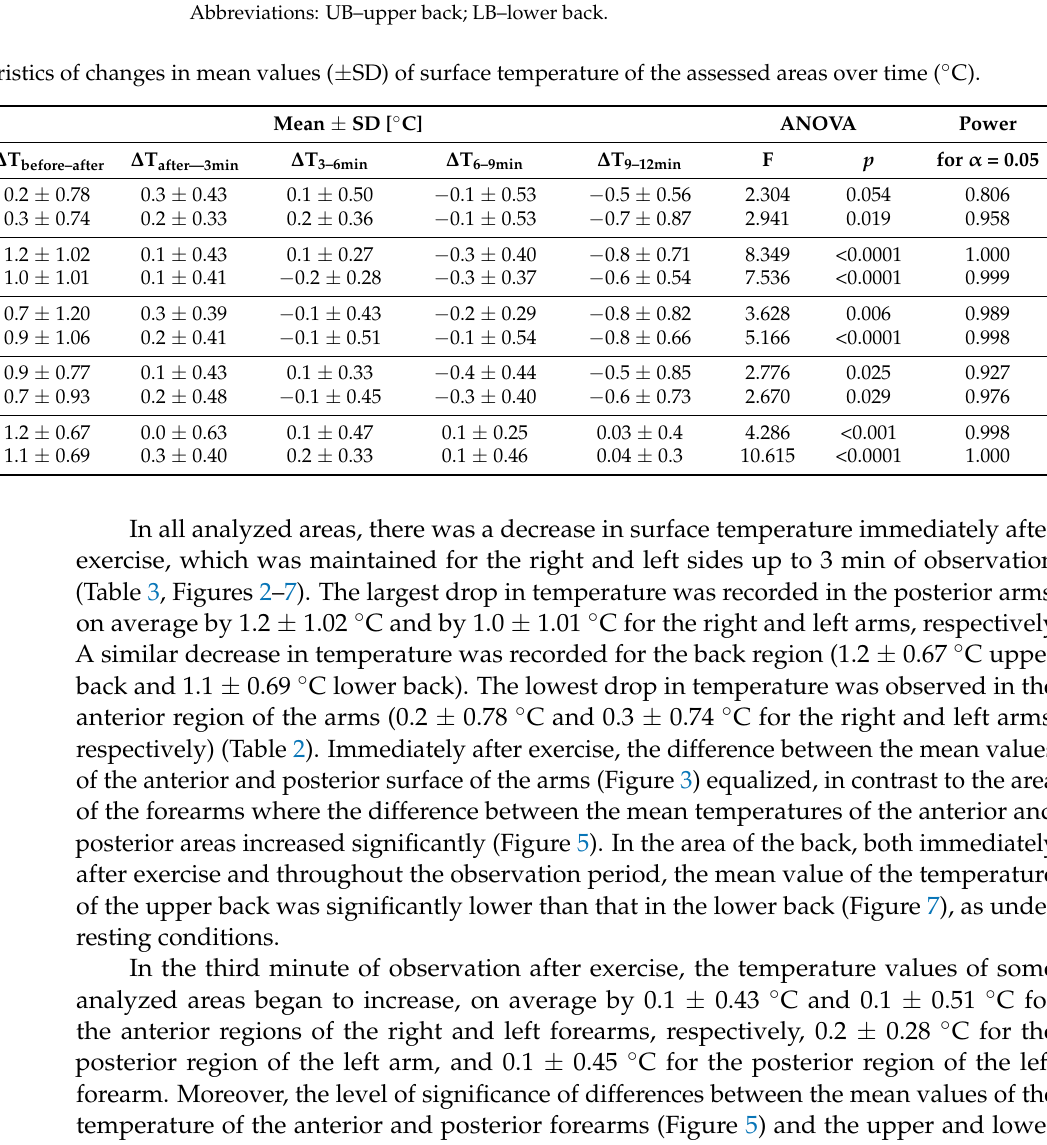
Table 2. Characteristics of the median values ( ± SD) of the distribution of surface temperatures in the back area ( ◦ C). Body Area